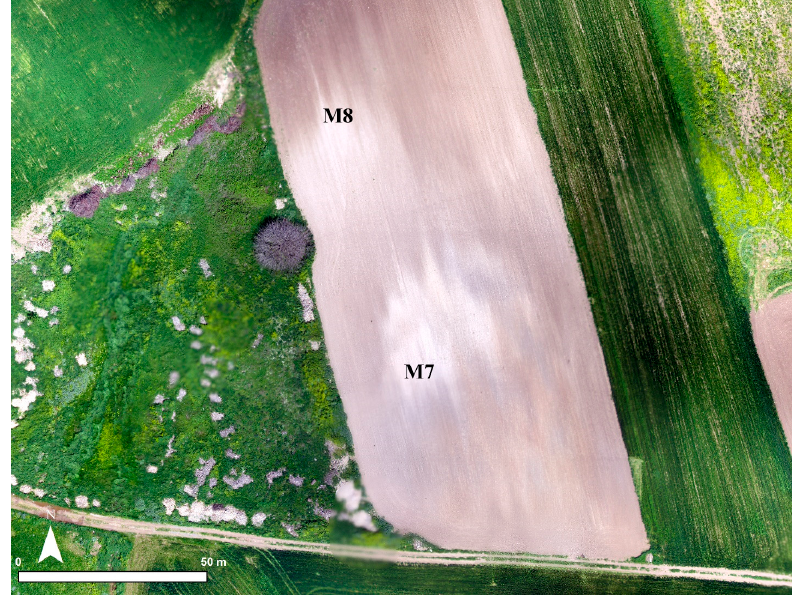
Figure 19. Droidworx RPAS imagery (acquisition date: 23April 2015) reveals two soil marks.